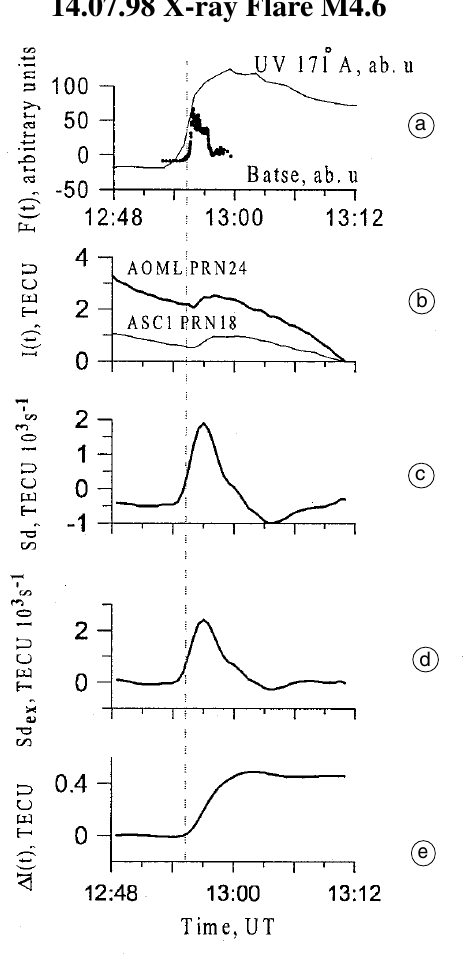
Fig. 4a-e. Bright solar flare July 14, 1998 (12:59 UT, M4.6/1B, S23E20). Time dependencies of hard X-ray emission (CGRO/Batse, 25-50 keV, thick line) and of the UV line (SOHO/SUMMER 171 Å, thin line) in arbitrary units (a); typical time dependencies of the TEC variations for separate LOS for stations AOML (PRN24, thick line) and ACSI (PRN18, thin line) (b); the normalized sum Sd of the time derivatives of the TEC variations for all LOS (c); same curve (c), upon subtracting the trend determined as a polynomial of degree 3 on the time interval 12:48-13:12 UT (d); the mean integral increment of TEC